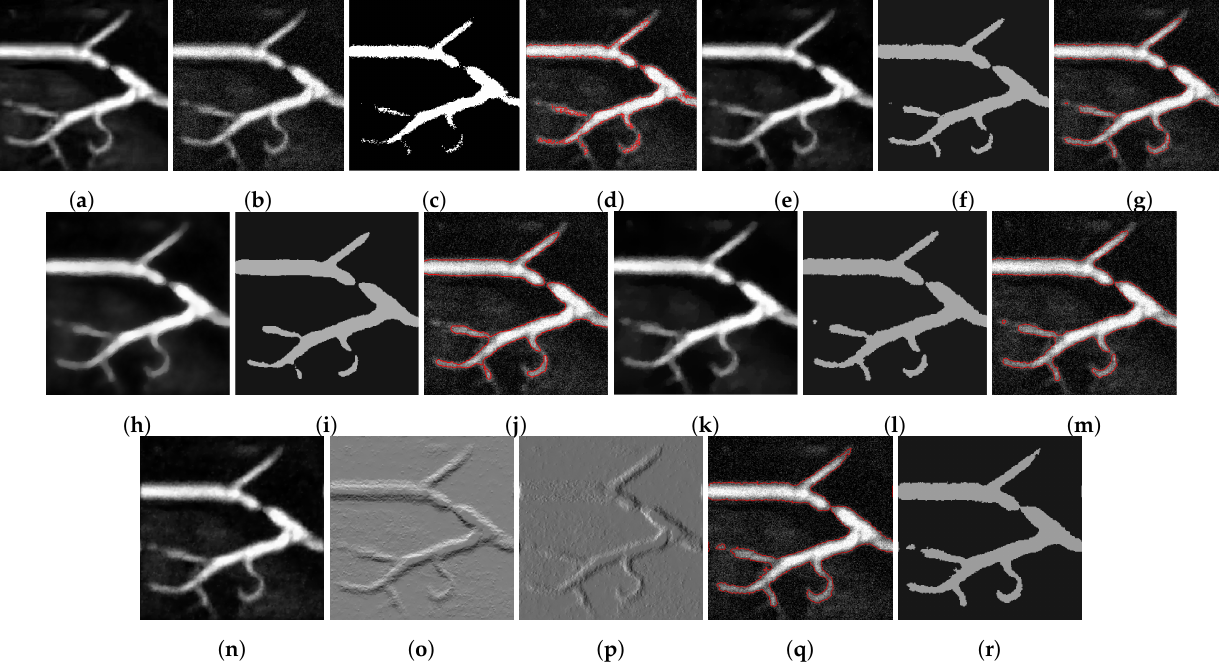
Figure 2. Results from a blood vessel image: ( a ) Clean image. ( b ) Noisy image used as input to the models. ( c ) Output of the CRCV model. ( d ) CRCV contour. ( e ) Output of CCZ. ( f ) CCZ after thresholding. ( g ) CCZ contour. ( h ) Output of CNC. ( i ) CNC after thresholding. ( j ) CNC contour. ( k ) Output of T-ROF. ( l ) T-ROF after thresholding. ( m ) T-ROF contour. ( n ) Output g of our model. ( o ) Output G x of our model. ( p ) Output G y of our model. ( q ) Ours after thresholding. ( r ) Our